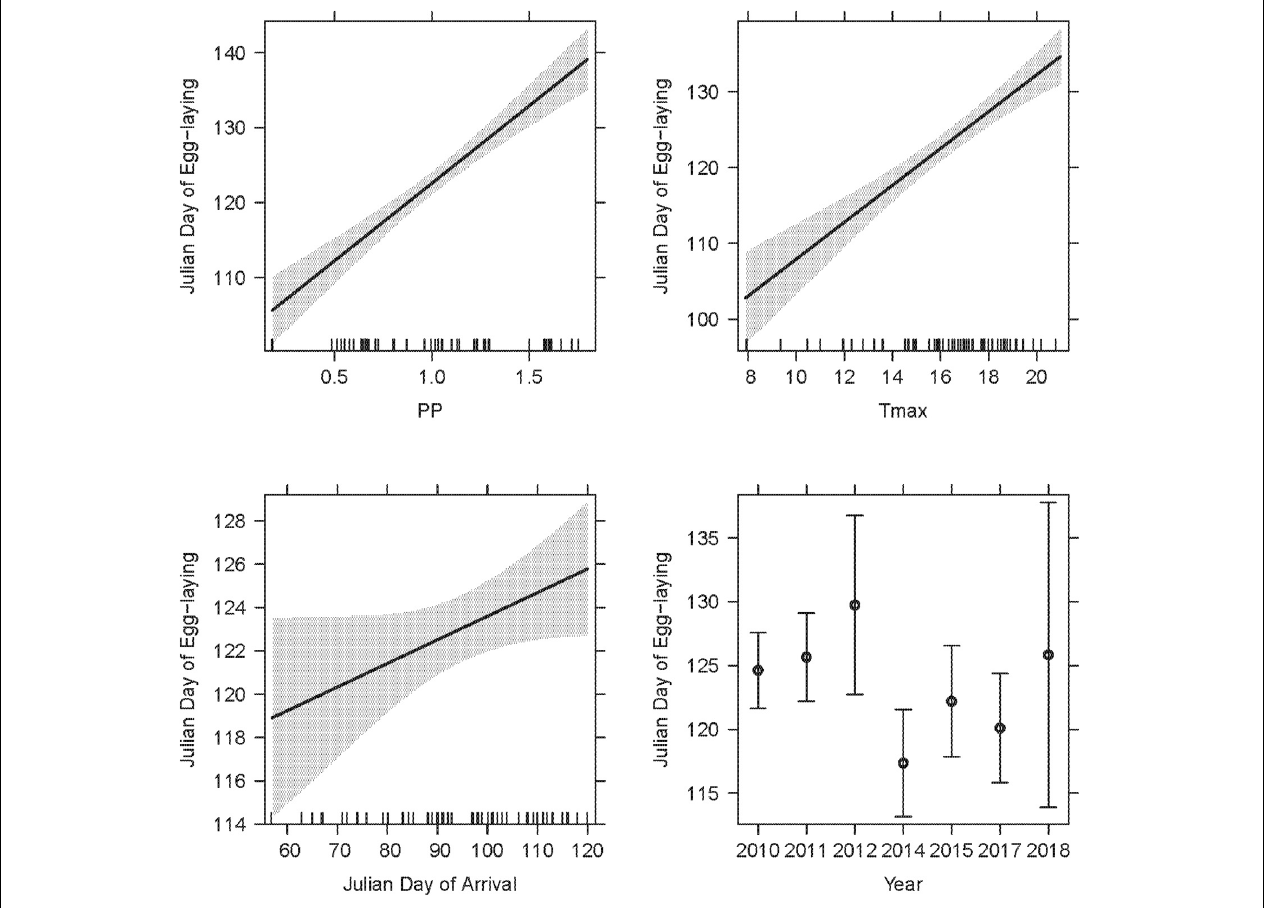
FIGURE 6 | The LMM on egg-laying dates from corresponding observations featured two weather variables (PP, T max ), year and arrival date as significant explanatory terms. SSF (not depicted) was not significant. The overall R 2 c of the LMM was 0.85. Model details in Table 2 .